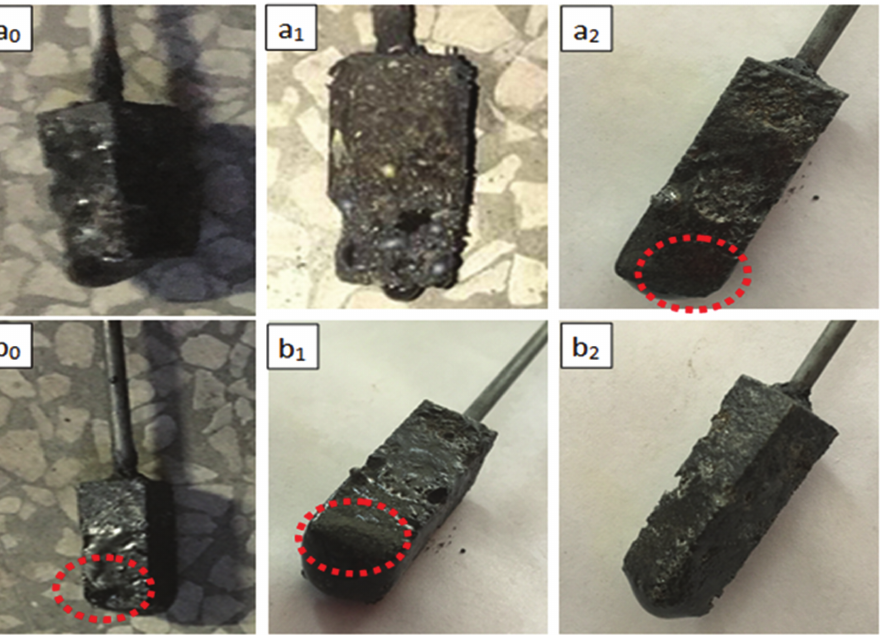
Figure 4: Appearance of MgO-C refractory corroded in different slag components (a-No.1 and b-No.2) (the subscript 0, 1 and 2 represent reference sample, anode and cathode, respectively)